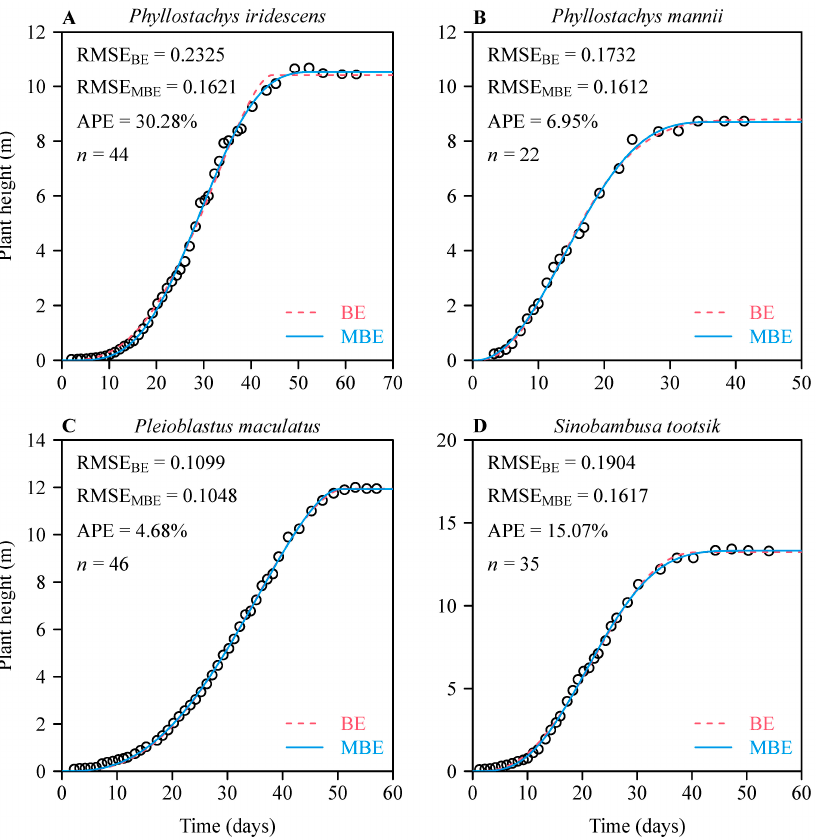
Figure 3. Results of fitting two sigmoid functions (based on the BE and MBE) to the shoot height versus time data of four species of bamboo. The small open circles represent the observed shoot height at different times (days) after the date when the shoot tip first emerged from the soil; the red dashed curves represent the height values predicted by the BE sigmoid equation; the blue solid curves represent the height values predicted by the MBE sigmoid equation. RMSE represents the root ‐ mean ‐ square error between the observed and predicted y values; APE represents the absolute percent error difference between the two equations’ RMSE values; n represents the sample size.